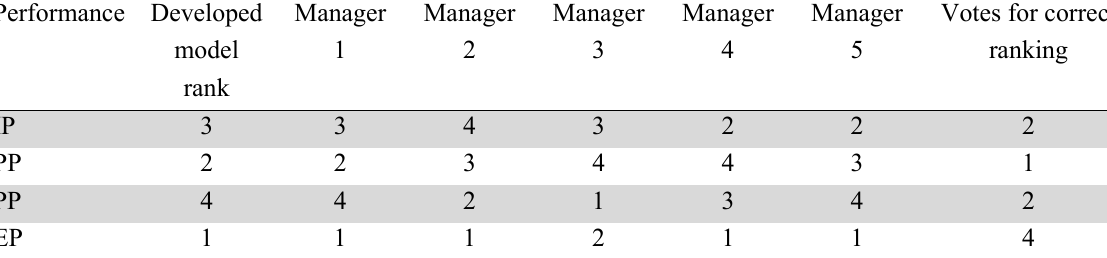
Comparison of Grey-TOPSIS and Experts